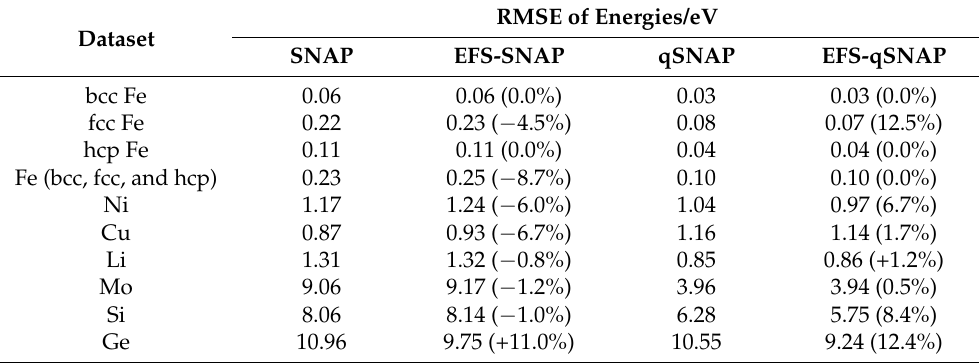
Table 2. RMSE comparison of energy between qSNAP and EFS-qSNAP.